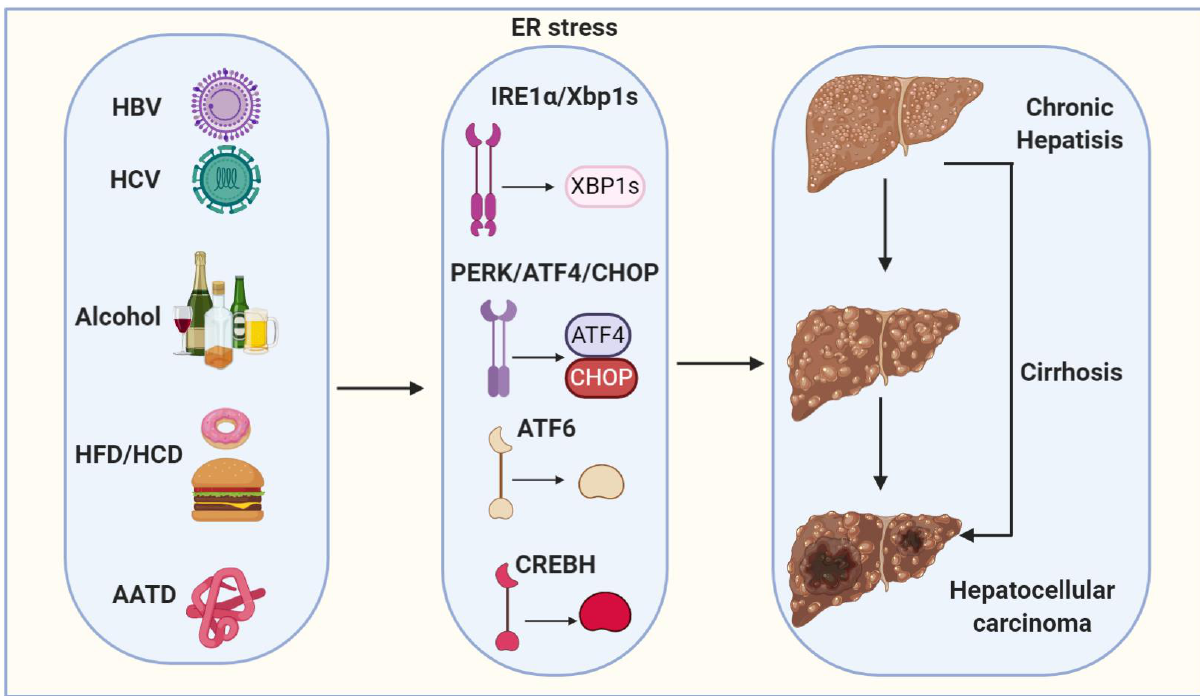
Figure 2. Proposed model depicts ER stress mechanisms linking viral infection, alcohol, high-fat diet/high-carbohydrate diet (HFD/HCD) and Alpha1-antitrypsin deficiency (AATD) with hepatocellular carcinogenesis (HCC). Viral (HBV and HCV) infection, alcohol, HFD/HCD and AATD induce and sustain ER stress. ER stress and steatosis increase reactive oxygen species (ROS) production to cause oxidative stress and inflammation and the subsequent genomic instability, cirrhosis and